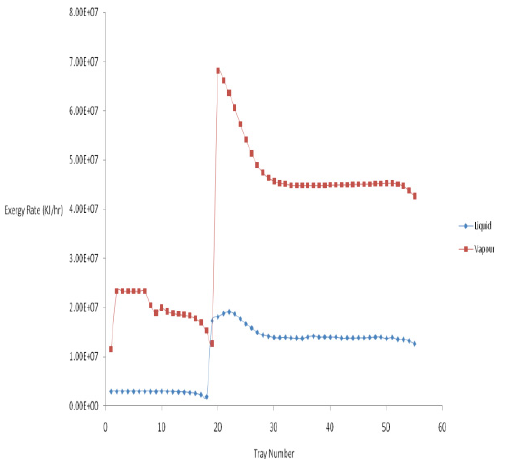
Figure 20. Profile of exergy rate versus tray number for Debutanizer of base case, 80 o C, Reflux Ratio 6